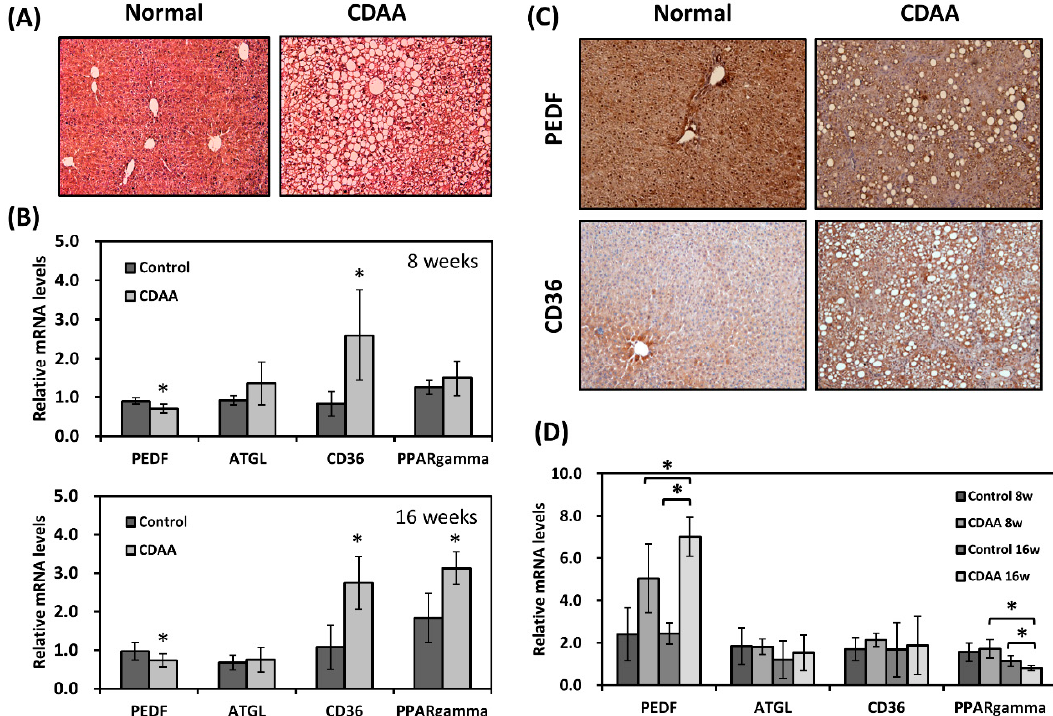
Figure 1. Decreased pigment epithelium-derived factor (PEDF) and increased CD36 were observed in hepatic steatosis. ( A ) Magnification: 100 × . C57BL / 6 mice were on a control or choline-deficient l -amino acid-defined (CDAA) diet for 8 weeks. Liver sections were stained with hematoxylin and eosin (H&E) for histological evaluation. ( B ) Hepatic gene expression was determined using quantitative RT-PCR. ( C ) Magnification: 100 × . Hepatic PEDF and CD36 proteins were stained using immunohistochemical analysis. ( D ) Gene expression in the adipose tissue was determined using quantitative RT-PCR. *, Statistically significant compared with the controls at p < 0.05. ATGL: adipose triglyceride lipase.